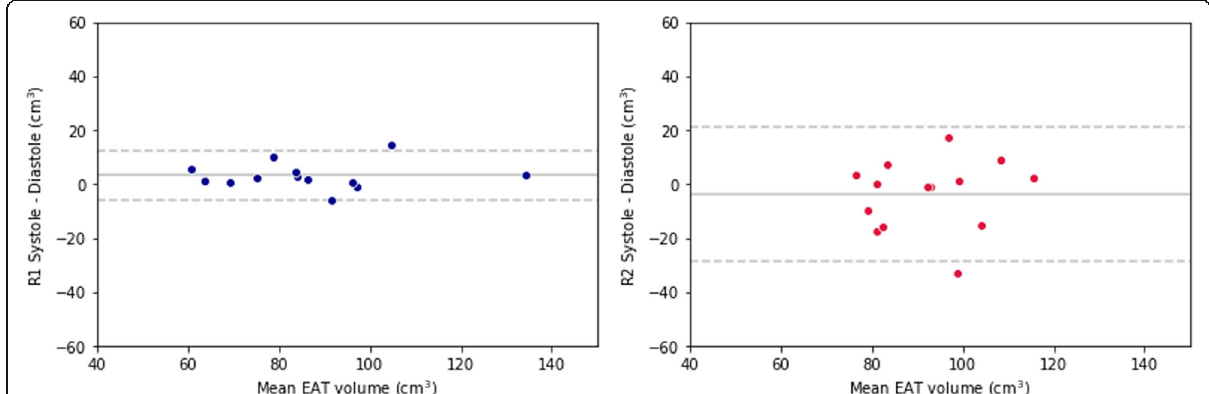
Fig. 4 Bland-Altman plots for inter-phase reproducibility between systole and diastole of epicardial adipose tissue volume for the two readers. Dashed lines represent 95% confidence intervals and are placed at ± 2 standard deviations. EAT, Epicardial adipose tissue; R1, Reader 1; R2, Reader